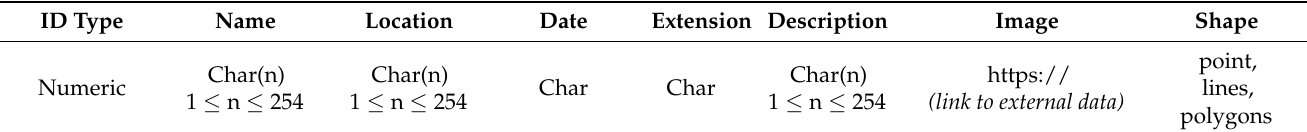
Table 5. Database structure in